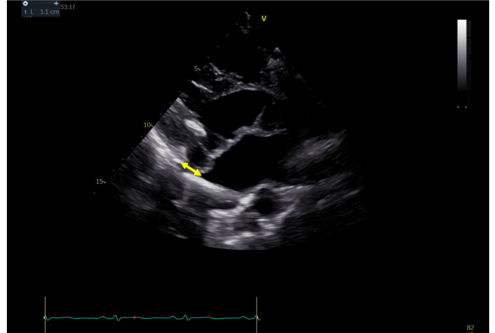
Figure 1. Transthoracic echocardiography (long-axis parasternal view) of MAD measurement in MAD+ patients. MAD distance is calculated as the length of systolic separation between the left atrial wall and mitral valve leaflet junction to the top of the left ventricle free